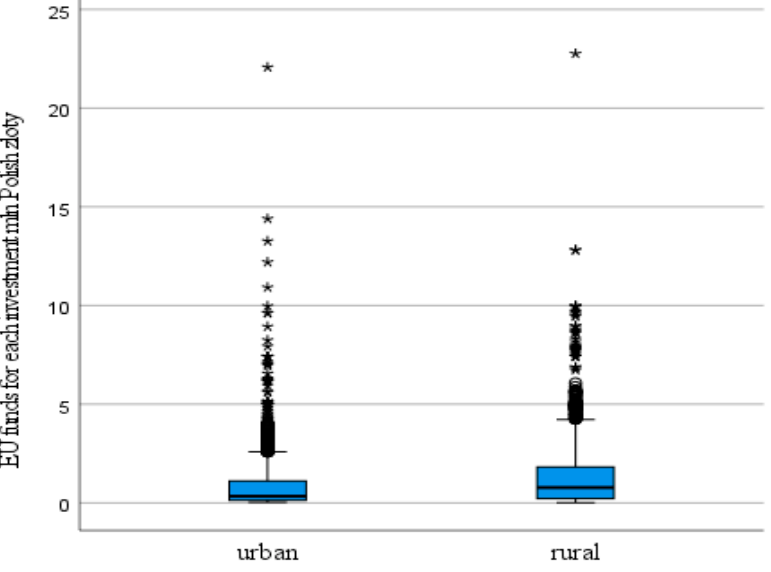
Figure 1. Boxplots of EU funds per solar renewable energy investment under operational programmes in 2014–2020 in urban and rural areas. Explanation: * shows the value of EU funding in mln Polish zloty for each solar RE investment in urban and in rural areas.